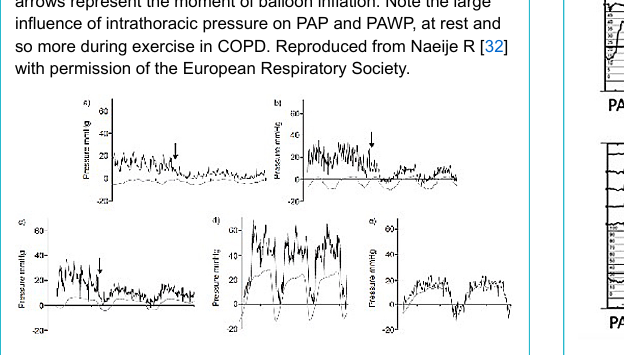
Figure 3: Simultaneous pressure recordings of pulmonary artery pressure (PAP) and pulmonary artery wedge pressure (PAWP) (black lines) with oesophageal pressure (grey lines) in (a) healthy subject at rest and (b) during exercise; and a COPD patient (c) at rest, (d) PAP during exercise and (e) PAWP during exercise. The arrows represent the moment of balloon inflation. Note the large influence of intrathoracic pressure on PAP and PAWP, at rest and so more during exercise in COPD. Reproduced from Naeije R [32] with permission of the European Respiratory Society.